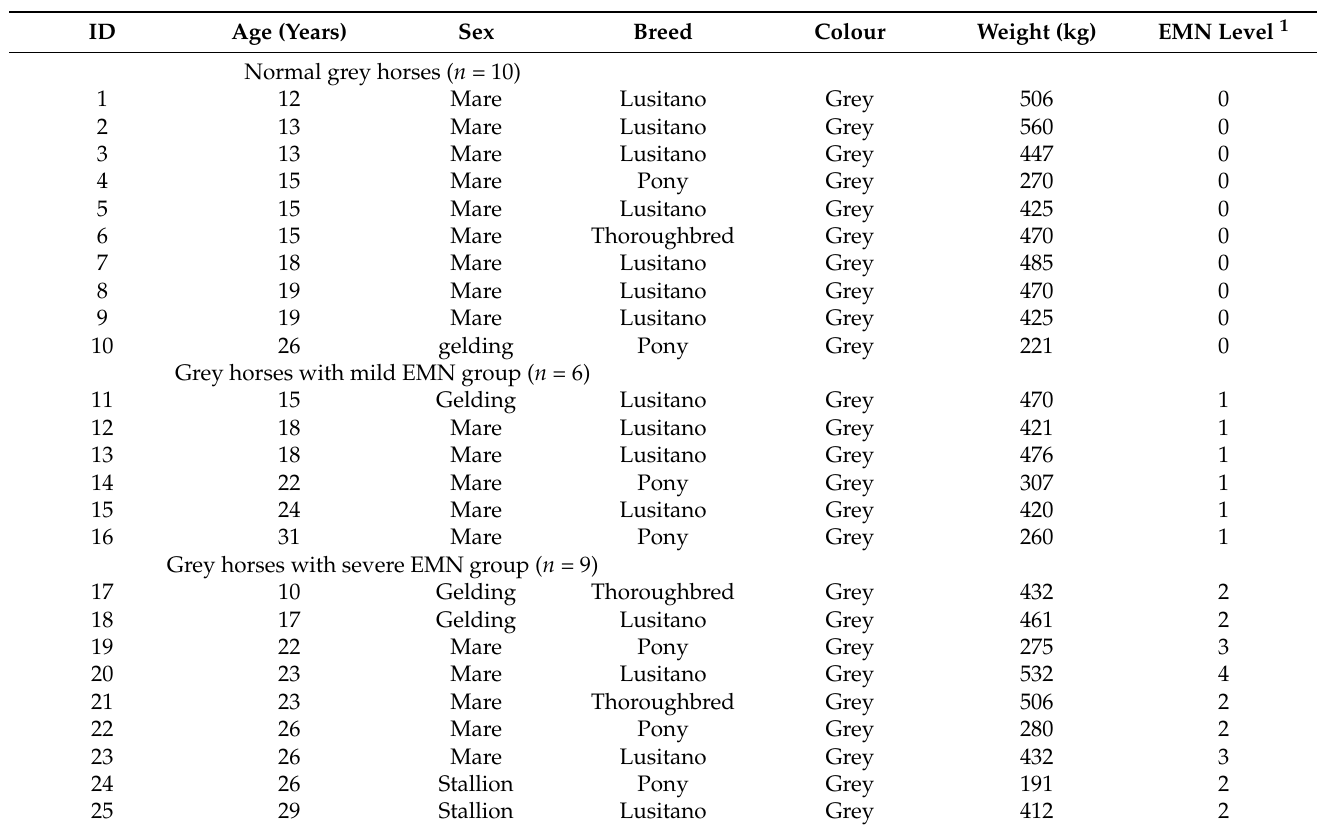
Table 1. Signalments, group classification and EMN levels of grey